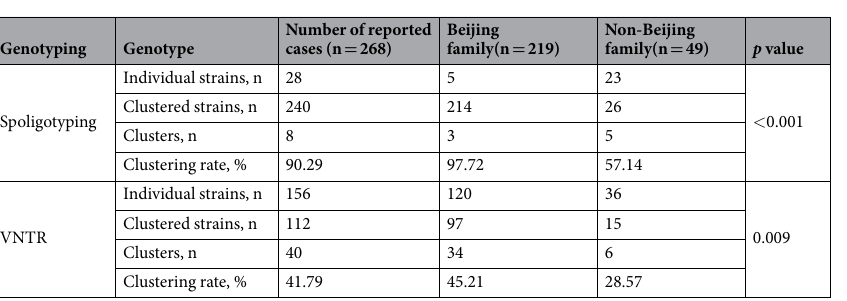
Table 3. Comparison of clustered and individual strains between the Beijing and non-Beijing family. ( p < 0.05 represents a statistically significant